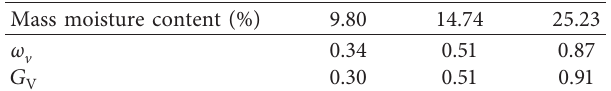
Figure 12: Gray histogram of the polyurethane thermal insulation board with different water contents. Table 8: Comparison of two algorithms for the polyurethane insulation